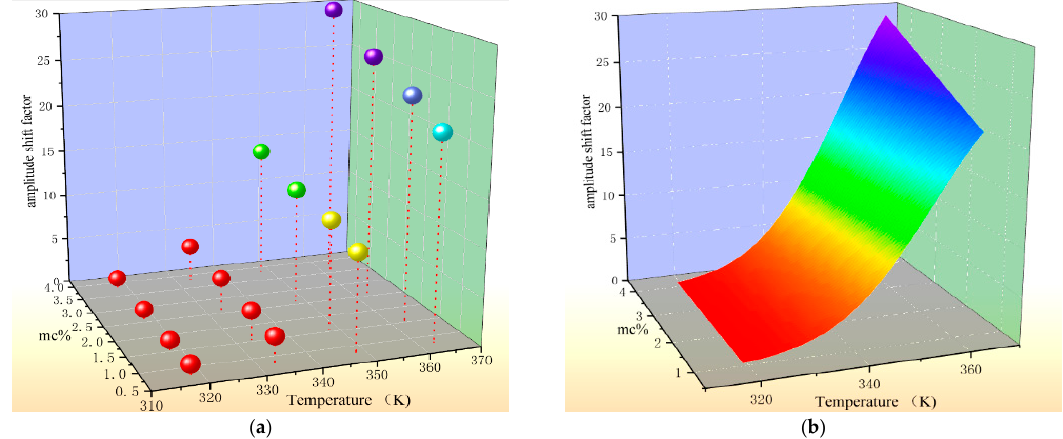
Figure 5. The variation law of amplitude-shift factor. ( a ) The scatter plot of test temperature, mc % and amplitude-shift factor; ( b )The fitting surface of the amplitude-shift factor.